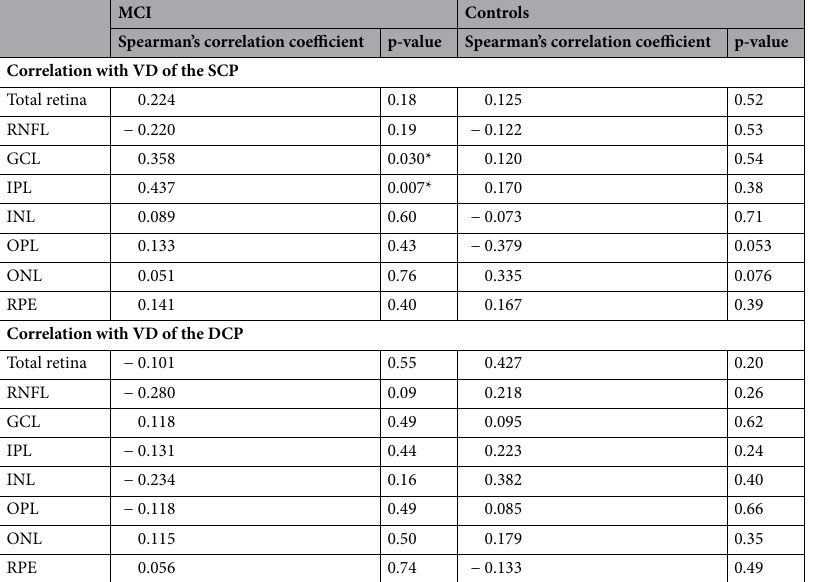
MCI Controls Spearman’s correlation coefficient p-value Spearman’s correlation coefficient